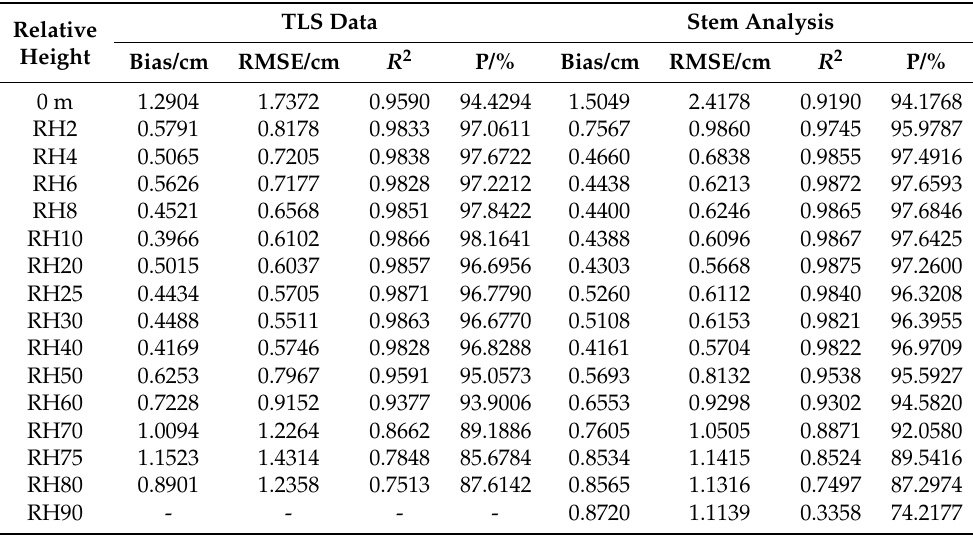
Table 12. Prediction of the diameter at different relative heights using the taper equation.